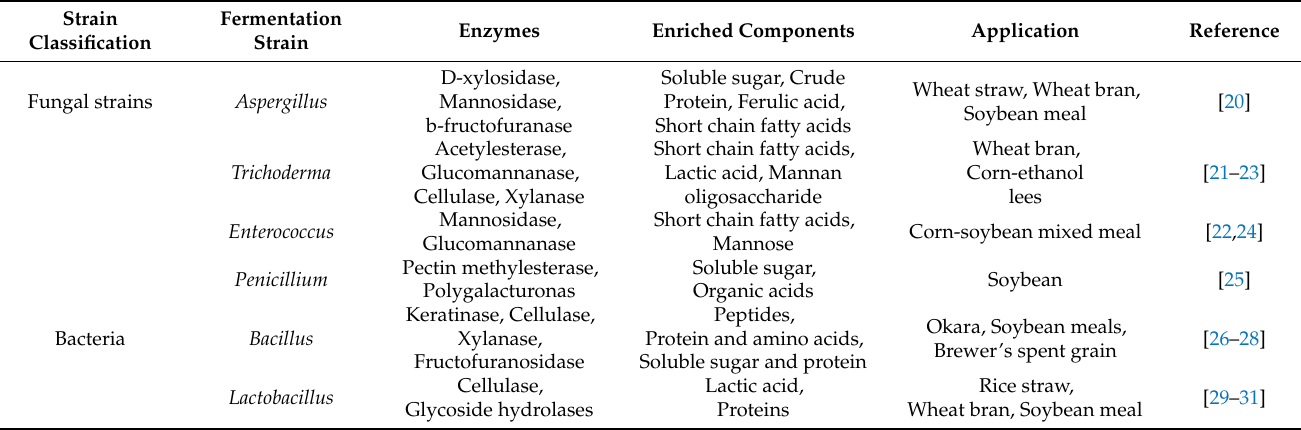
Table 3. Fermentation strain inoculation for non-starch polysaccharides